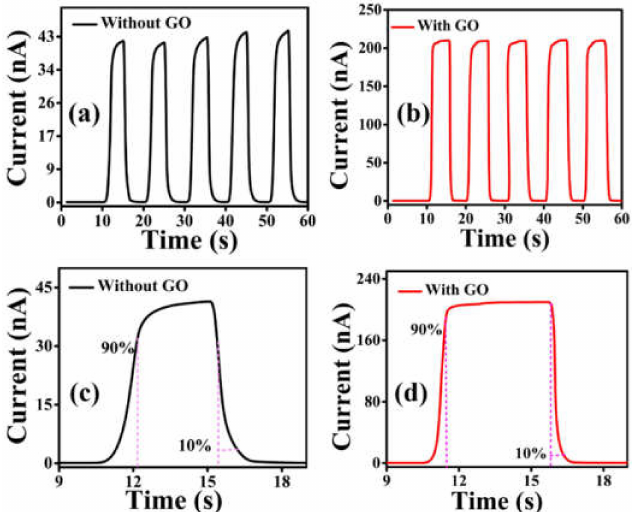
Figure 6. Time-dependent photocurrent response of ( a ) single layer (without GO) and ( b ) trilayer (with GO) photodetector measured at a bias voltage of 5 V and illumination power of 0.1 mWcm − 2 . One cycle photo response of ( c ) the single layer device and ( d ) the trilayer device for extraction of the rise and decay